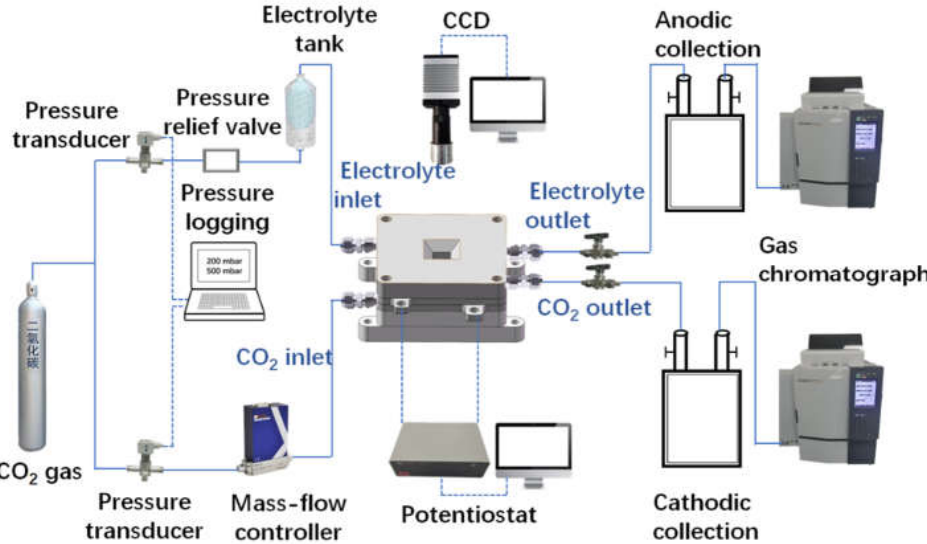
Figure 1. Schematic diagram of the extraterrestrial artificial photosynthesis system.